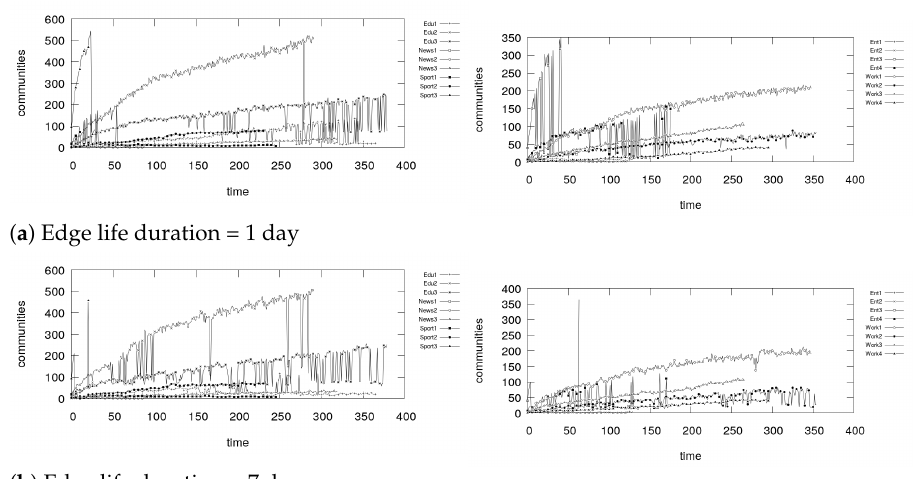
Figure 6. Number of communities detected by label propagation.